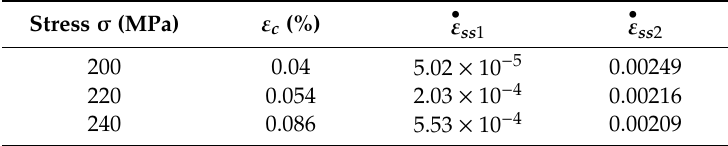
• • ε ε • • ss 2 ) at two steady-state stages of the Al-Li-S4 ss 1 , 𝑠𝑠1 , 𝜀 𝑠𝑠2 ) at two steady-state stages of the Al-Li-